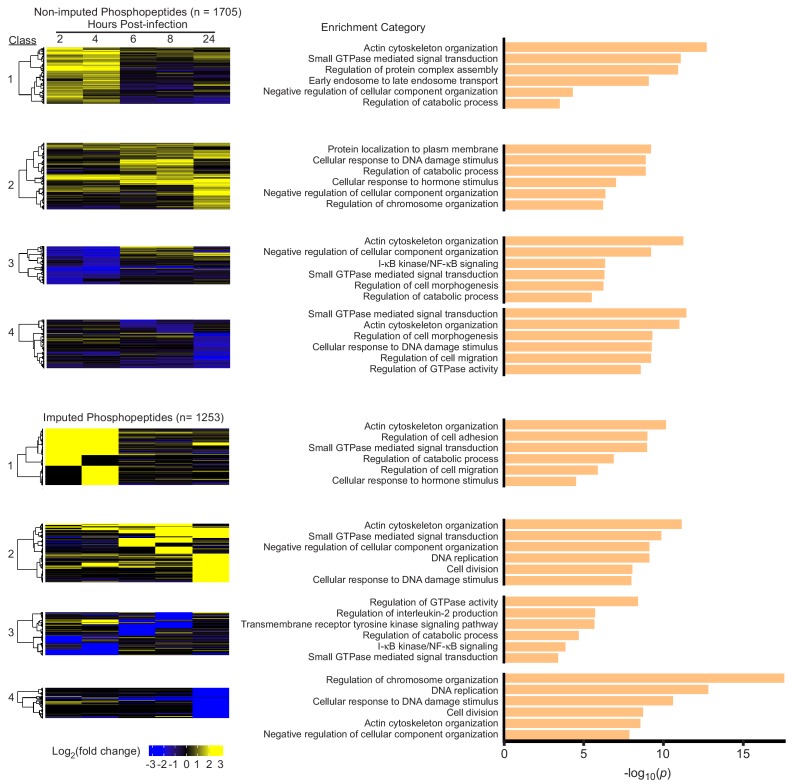
Changes in host protein phosphorylation during Mtb infection.(A) Cluster analysis and heat map displaying the log2(fold change) in phosphorylated peptide levels for non-imputed and imputed proteins with a p value less than 0.05. The most statistically significant functional enrichment term and representative proteins are indicated for each class of proteins. (B) Heat map visualization of functional enriched terms for each protein class. Statistical analysis of phosphopeptide data was performed with artMS version 0.9.